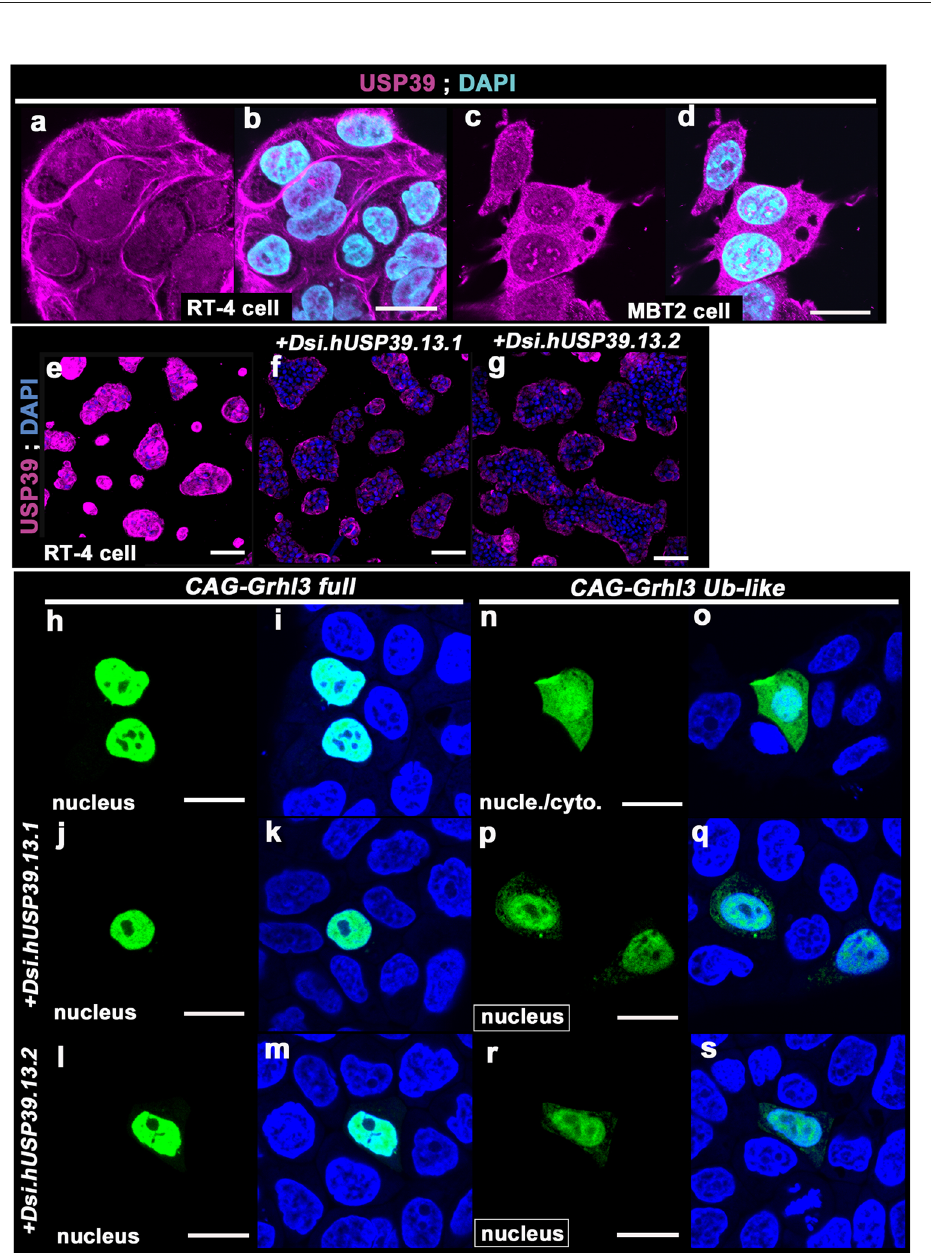
Fig. 2 Localization of Ub-like domain of GRHL3 overlapping with USP39 expression. a – d Ubiquitin-speci fi c protease 39 (USP39) proteins are endogenously expressed strongly in the cytoplasm and weakly in the nucleus of RT4 ( a , b ) and MBT2 ( c , d ) cells. Ubiquitin-speci fi c protease 39 (USP39) proteins (magenta) and 4,6 ′ -diamidino-2-phenylindole (DAPI; light blue). e – g Immunohistochemistry of USP39 expression in RT4 cells exposed to Dsi.hUSP39 for 24 h. USP39 proteins are present in most clumps of RT4 cells ( e ). USP39 protein is signi fi cantly decreased by treatment of cells with two different sequences of Dsi.hUSP39 ( f , g ). h – s Subcellular localization of two types of grainyhead-like 3 (GRHL3) products: full length ( h – m ) and Ub-like domain ( n – s ) fused to enhanced green fl uorescent protein (EGFP), respectively, and transfected into RT4 cells. The full-length GRHL3 fused to EGFP is localized to the nucleus ( h , i ), whereas a GRHL3 – Ub-like domain fused to EGFP is localized in both the nucleus and cytoplasm ( n , o ). The Ub-like GRHL3 fused with EGFP localized mainly in the nucleus after transfection with Dsi.hUSP39 ( p – s ), while full-length GRHL3 fused to EGFP was not affected by Dsi.hUSP39 ( j – m ). Experiments were performed in duplicate. Scale bars represent 20 μ m ( a – d , h – s ) and 100 μ m ( e – g